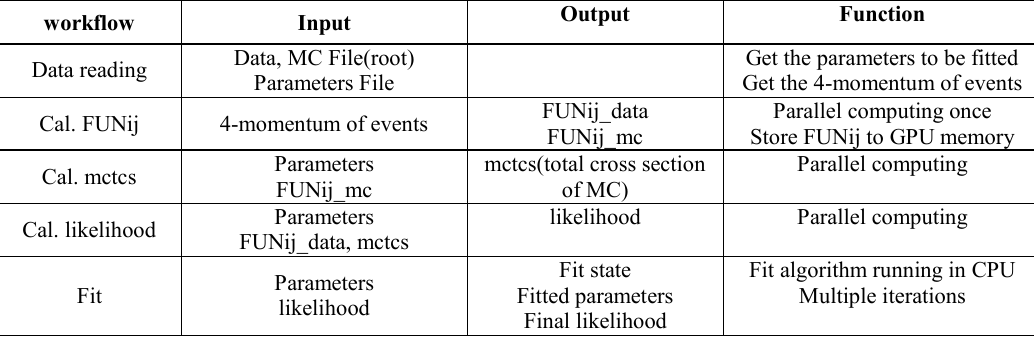
Table 1. Workflow of OpenAccPWA